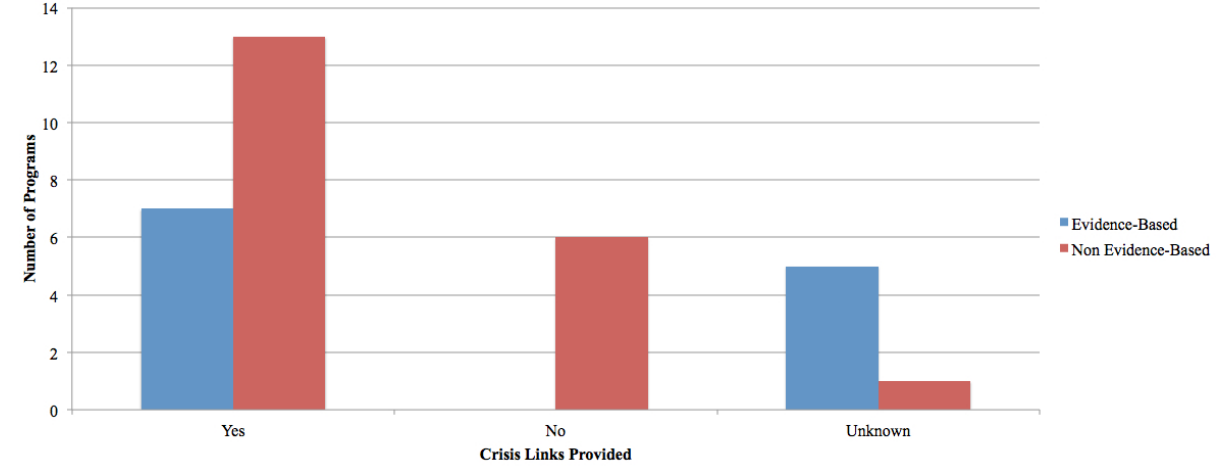
Figure 10. Crisis link information